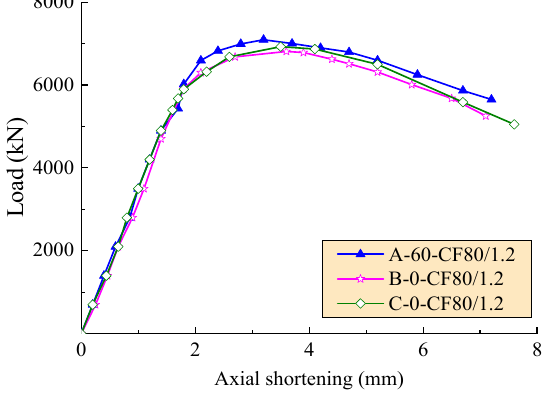
Figure 8. Axial load-deformation curves with a varying stiffener type.